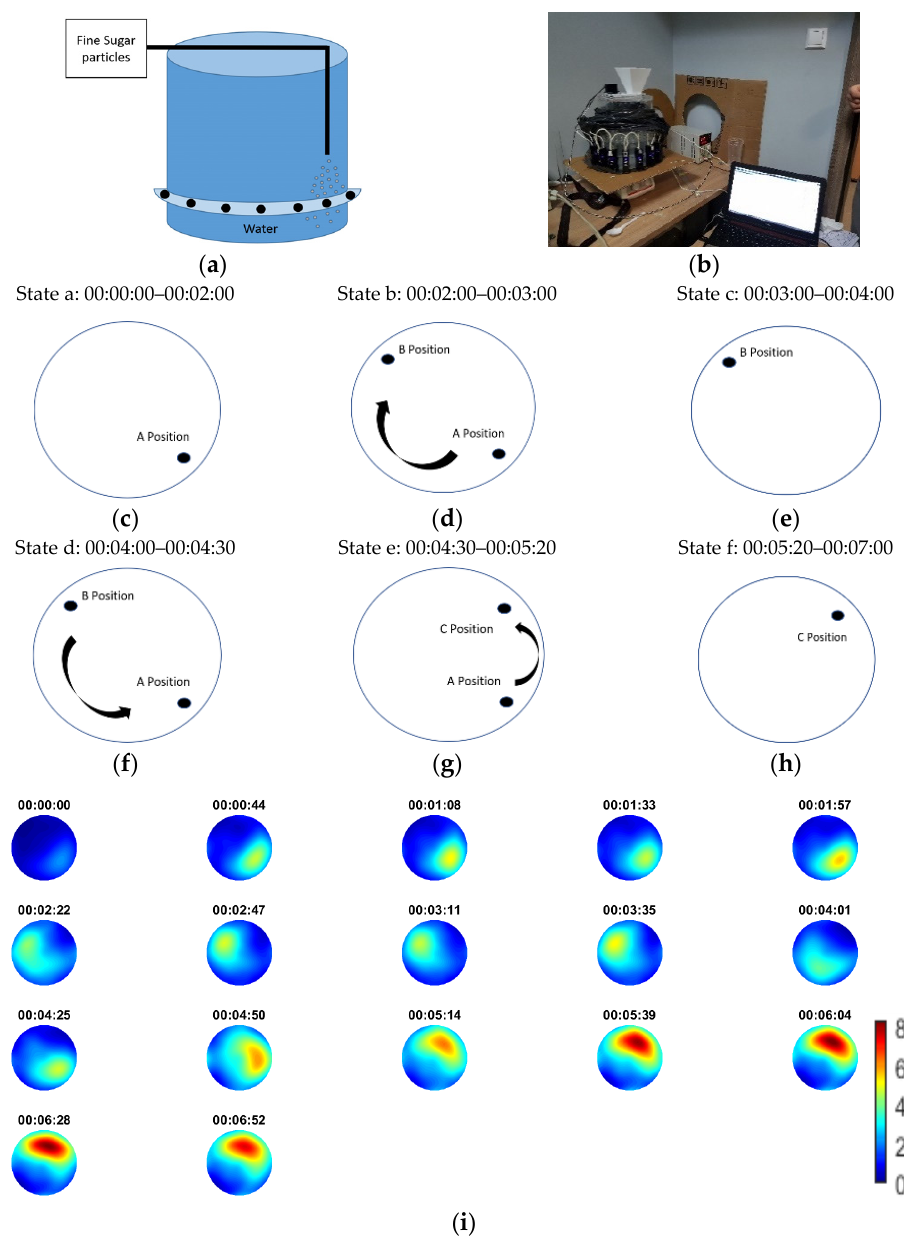
Figure 5. ( a ) Schematic of the tank. ( b ) Experimental apparatus photo. ( c – h ) Graph explaining the shifting of injection position. ( i ) Reconstruction of time-of-flight (TOF) delays with the specific capture time. Scale bar describes pulses’ travel-time delays of the first pulse. The reconstructions agree with the injection’s shifting position. The intermittent injection drove a continuous change of particles’ concentration over time, being at a high then lower and then higher level, again. This change of the particles’ concentration within the field of view translated into higher then lower and then higher again delays of TOF signals. After 4:30 min from the start of the process, the injection point passed through position A again, which drove of sugars in the region to higher concentration. Therefore, one can notice a significant increase of TOF delays in the last reconstructed frames. Moreover, the injection stayed a bit longer between position A and C and, subsequently, as the experiment approached the end, bigger TOF delays could be